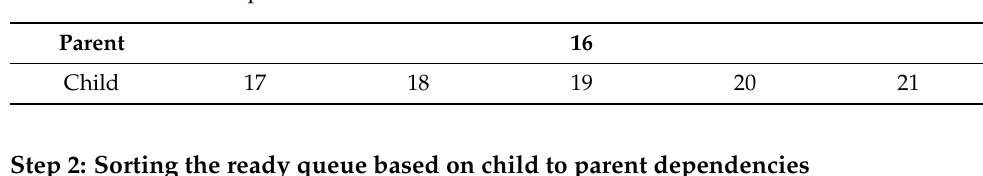
Table 3. Creation of the parent-child table at level 4.